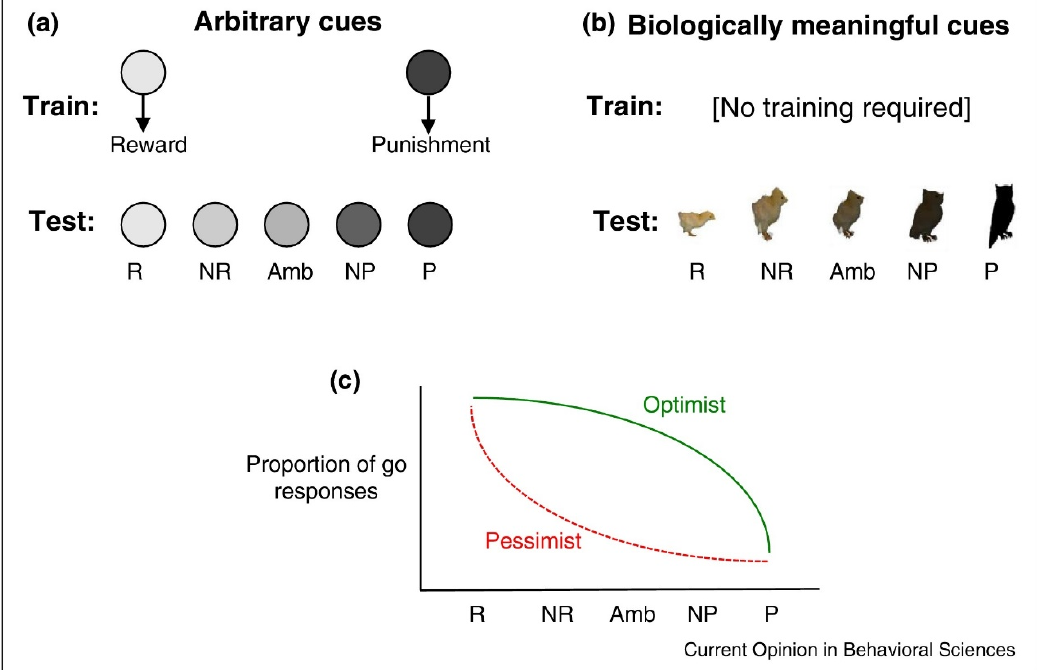
Figure 1. Methodology used in Judgment bias tasks (From [11]) ( a ) Description of what is contained in the first panel; ( b ) Description of what is contained in the second panel; ( c ) Description.